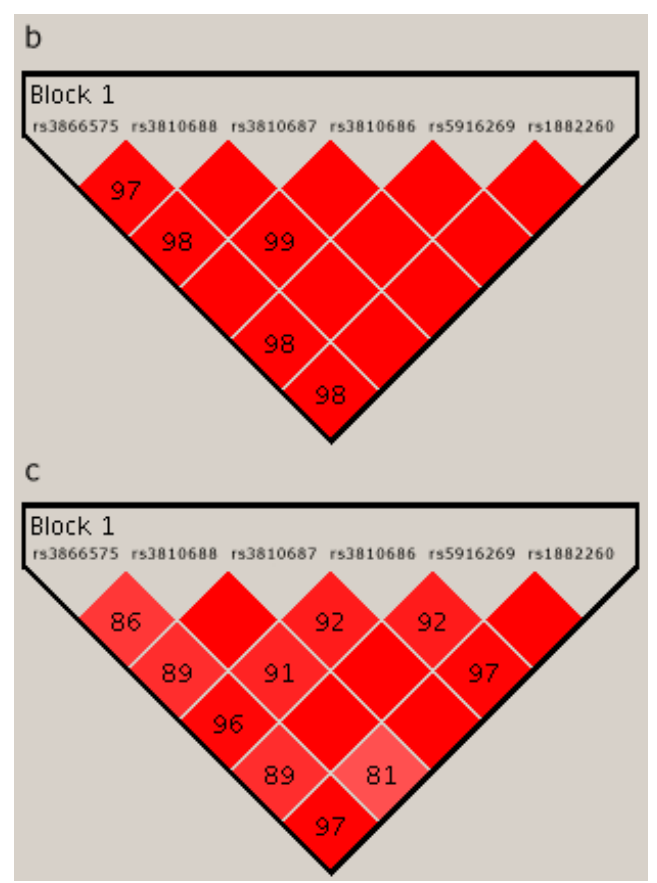
Figure 1. Linkage disequilibrium (LD) for the SNPs analyzed in NLGN4X calculated using Haploview: in panel ( a ) for the EUR population (1000 Genomes Project, Phase 2); in panel ( b ) for the Italian control population; and in panel ( c ) for the autistic patients enrolled in our study.